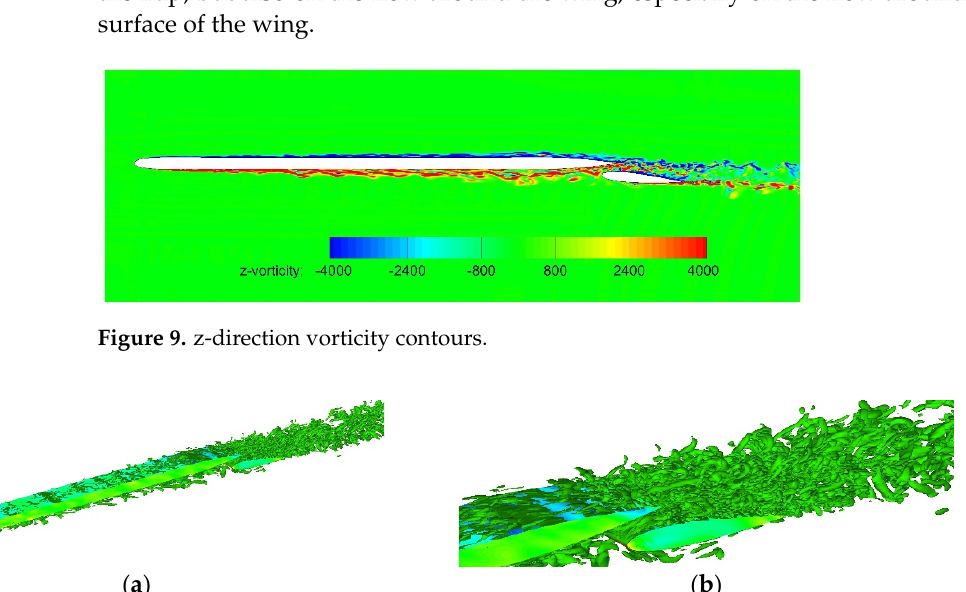
Figure 10. Iso-surfaces of Q-criterion (Q = 5000) for the case with the deflection angle of 0°: ( a ) the whole view; ( b ) zoom-in view near the flap.